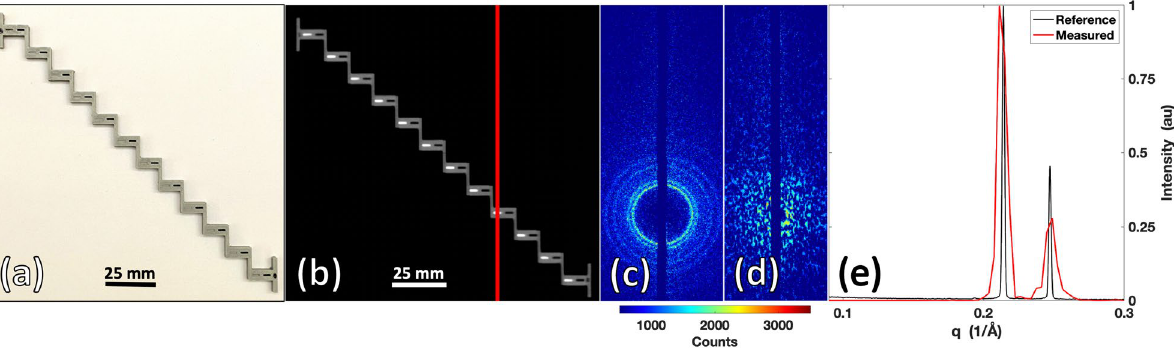
Figure 2. 3D printed phantom with 1 × 4 × 3 mm 3 wells for measuring aluminum powder in the X-ray fan beam coded aperture imaging system. ( a ) Photograph of the phantom. ( b ) X-ray transmission scan of phantom, showing aluminum powder in the left well of each step with right wells empty. ( c ) XRD scatter rings of aluminum (empty PLA well subtracted) without a coded aperture, acquired when fan beam was at the location of the red line in ( b ), showing distinct rings with higher intensity scatter of X-rays. ( d ) Encoded XRD scatter (from aluminum and PLA) passing through a coded aperture, creating spatially unique modulations that can be utilized to reconstruct XRD spectra along the fan beam. ( e ) XRD spectra of aluminum powder measured by inputting the data from ( d ) into a reconstruction algorithm based on the modeled physics of the imaging system, demonstrating accurate identification and measurement of aluminum in the phantom. MATLAB (v2020a) was used for the visual display of all X-ray data presented within this figure and all other